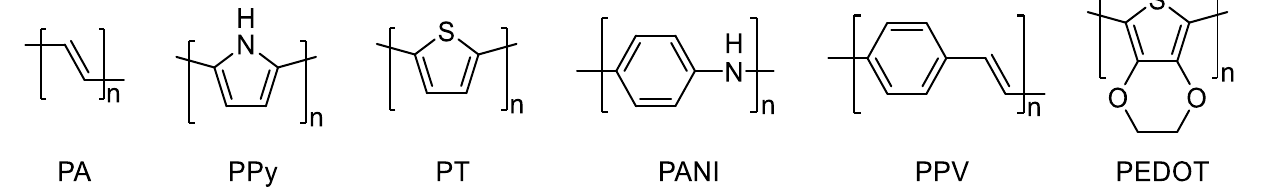
Figure 1. Chemical structures of the repeat units of some representative CPs; from left to right: polyacetylene (PA), polypyrrole (PPy), polythiophene (PT), polyaniline (PANI), poly(phenylene vinylene) (PPV), and poly(3,4-ethylenedioxythiophene (PEDOT).